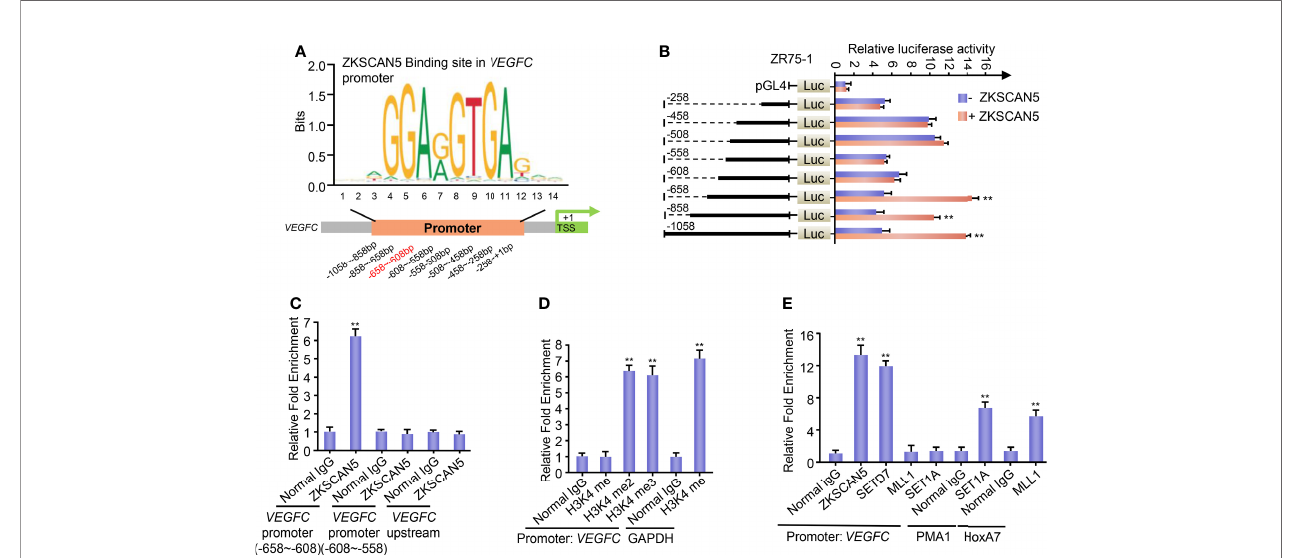
FIGURE 4 | (A) Conserved binding sequences of the transcription factor ZKSCAN5 (JASPAR: http://jaspar.genereg.net/) and its binding sites to the VEGFC promoter. (B) Luciferase activity of various VEGFC promoter constructs in ZR75-1 cells transfected with ZKSCAN5 or empty vector. Data shown are the mean ± SD of triplicate measurements and were repeated three times with similar results. **p < 0.01 versus empty vector with corresponding promoter reporter. (C) ChIP analysis of the occupancy of ZKSCAN5 on the putative ZKSCAN5-binding sites of the VEGFC promoter in ZR75-1 cells. (D) ChIP analysis of the occupancy of H3K4me, H3K4me2, and H3K4me3 on the VEGFC promoter in ZR75-1 cells. The GAPDH promoter has the function of H3K4me2- and H3K4me3-positive control. (E) ChIP analysis of the occupancy of ZKSCAN5 and different histone methyltransferases on the VEGFC promoter in ZR75-1 cells. Positive controls of SET1 and MLL1 were promoters of PMA1 and HoxA7,